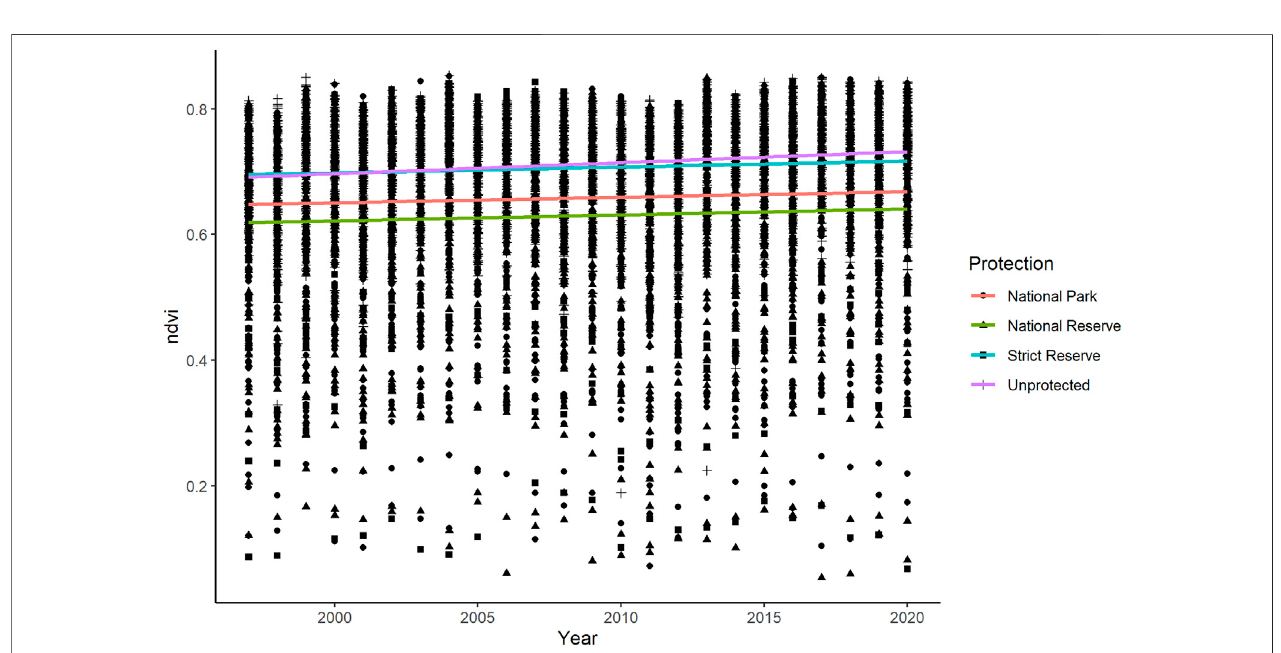
Frontiers in Remote Sensing |